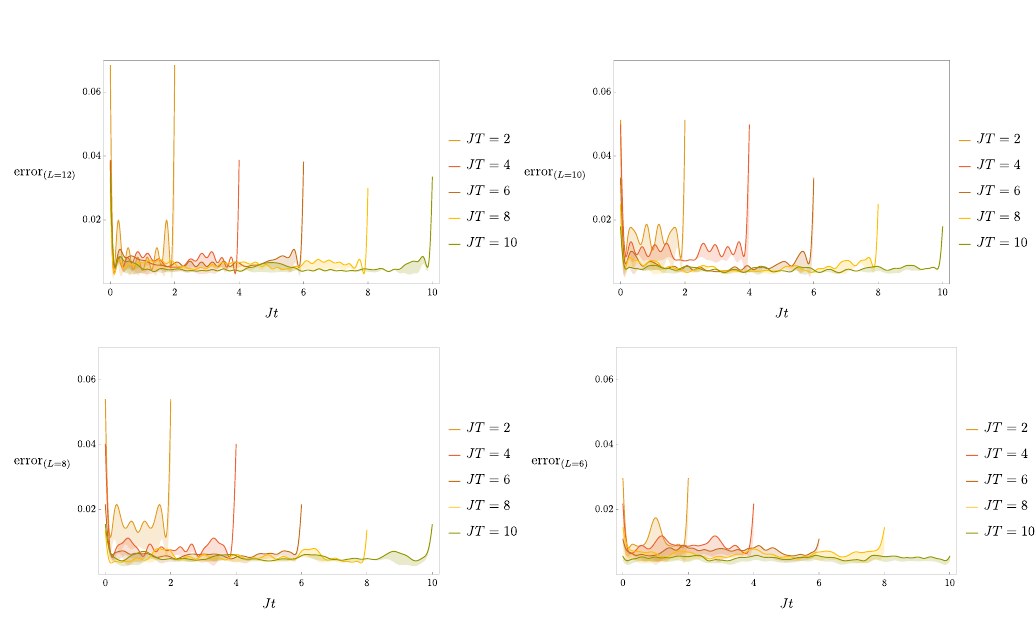
∼ t − 1 Figure 5: The error on the state at time t induced by the Ansatz ε 2 (specif- t = 0.15 / (cid:112) ically, ε 1 + 100 Jt ) for the same parameters as in figure 4 in chains with t L = 12,10,8,6 sites. Each curve corresponds to projecting onto the reduced space associated with the time window [ 0, T ] . The shades below the curves represent an indetermination coming from the fact that ε can be enforced only approximately t because the error made by reducing the space is in fact quantised.